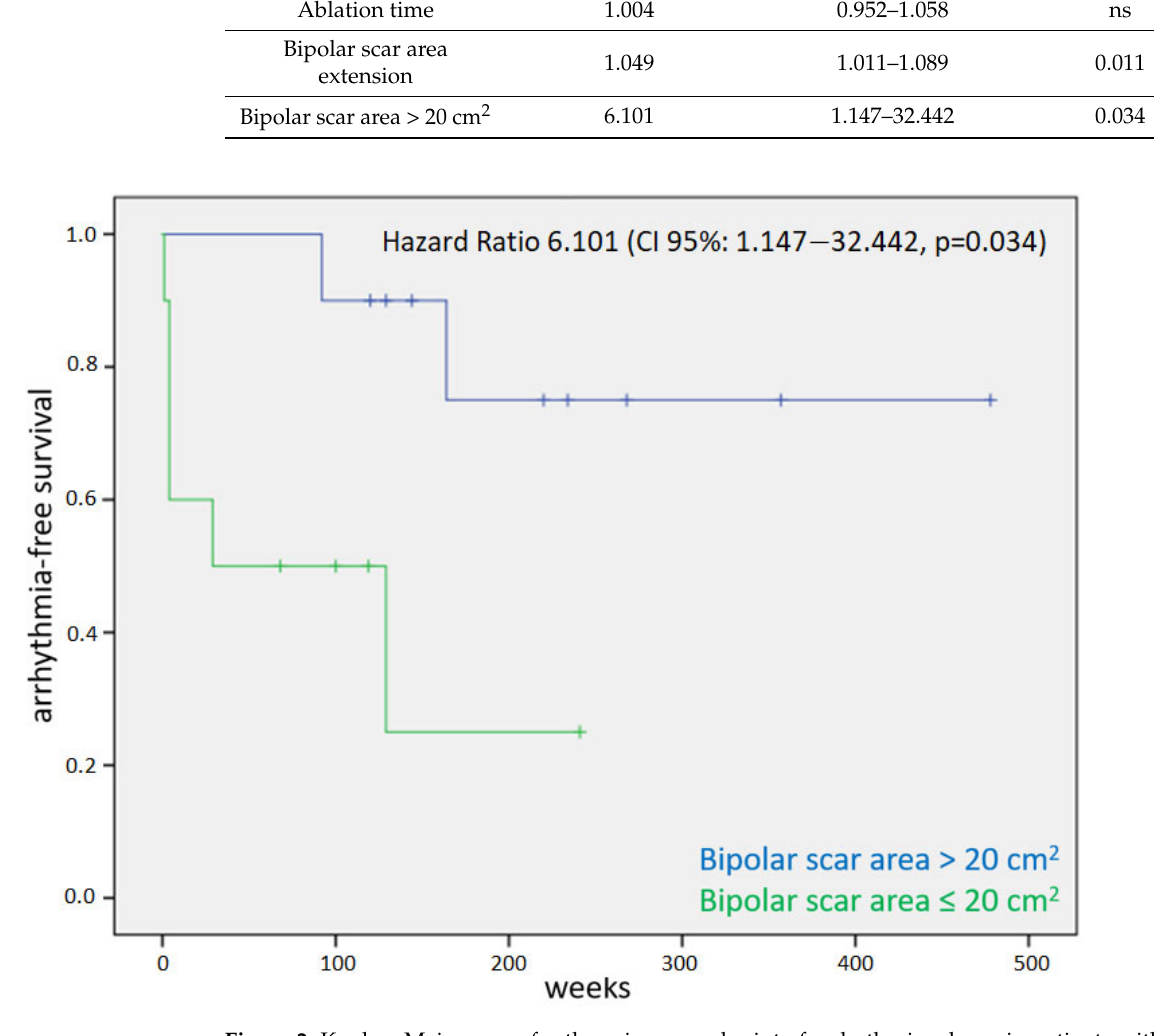
Figure 2. Kaplan–Meier curve for the primary endpoint of arrhythmic relapse in patients with and without an extension of bipolar scar >20 cm 2 .